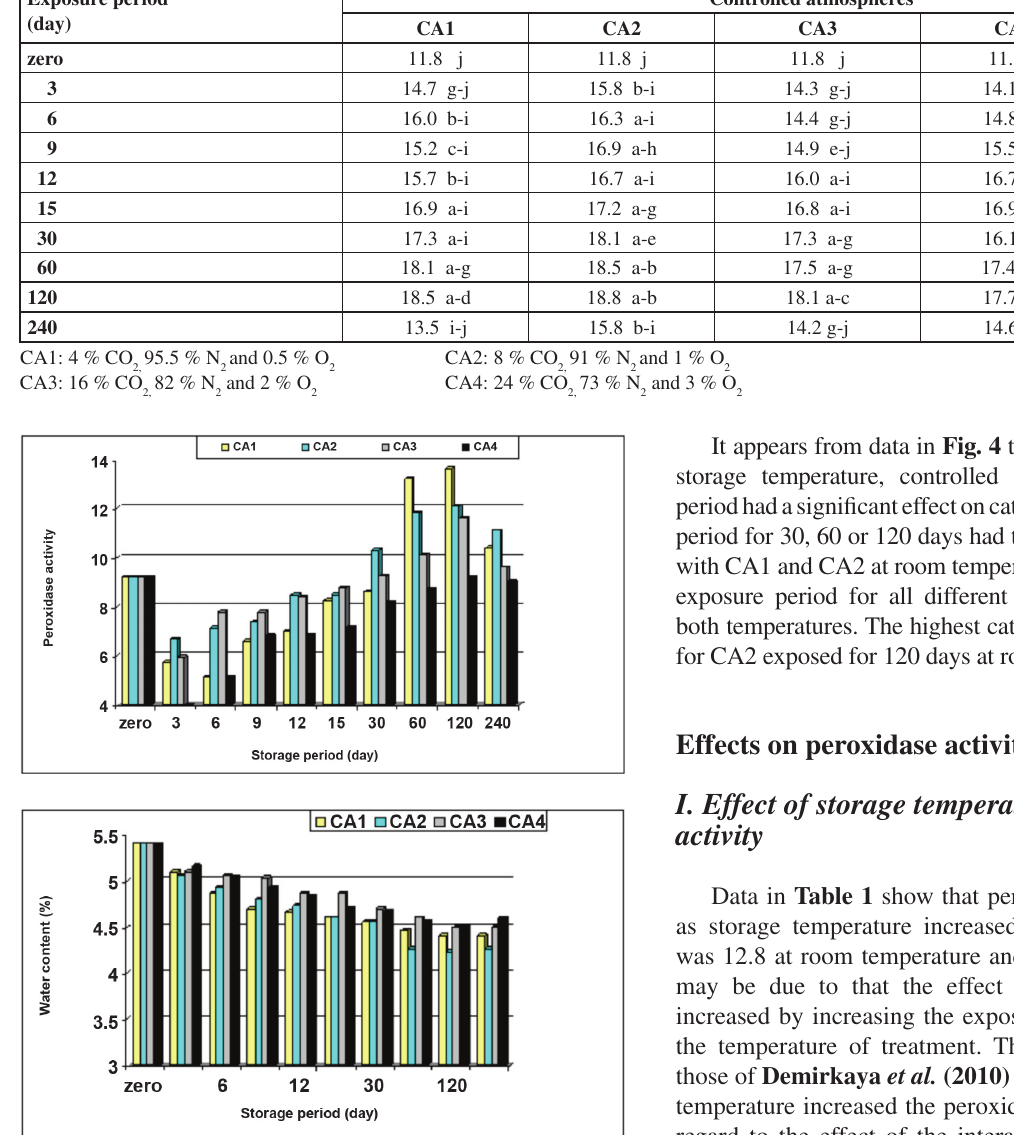
Table 3: Effect of exposure period and different controlled atmospheres on catalase activity of onion seeds stored for 12 months Exposure period (day)